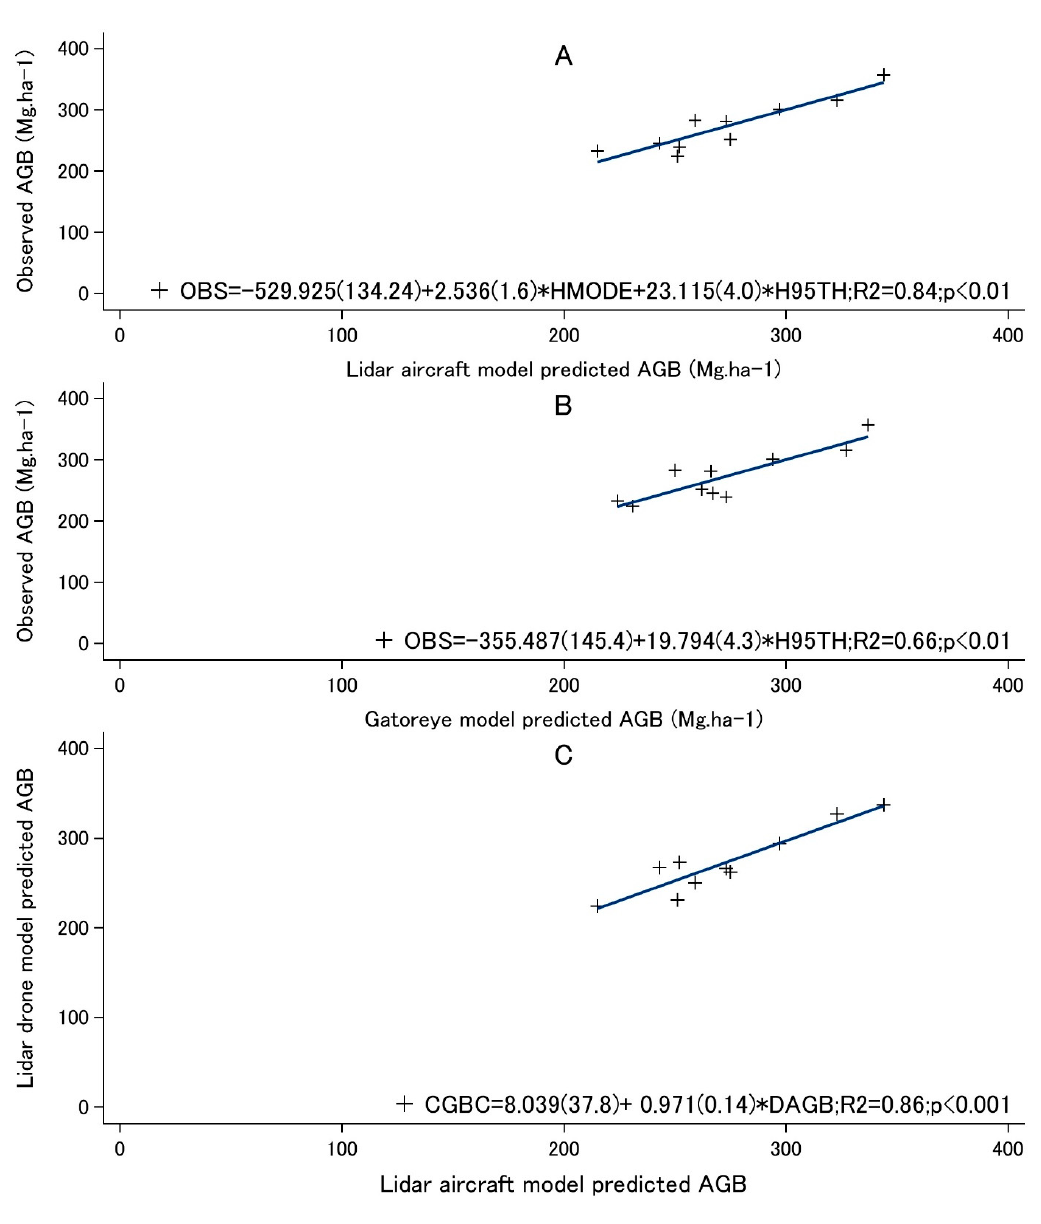
Figure 6. Predicted versus observed ground plot values for aboveground biomass (Mg · ha − 1 ) for models produced by the ( A ) aircraft system and ( B ) GatorEye system, and ( C ) their comparison. Numbers in parentheses are the standard errors for each coefficient.